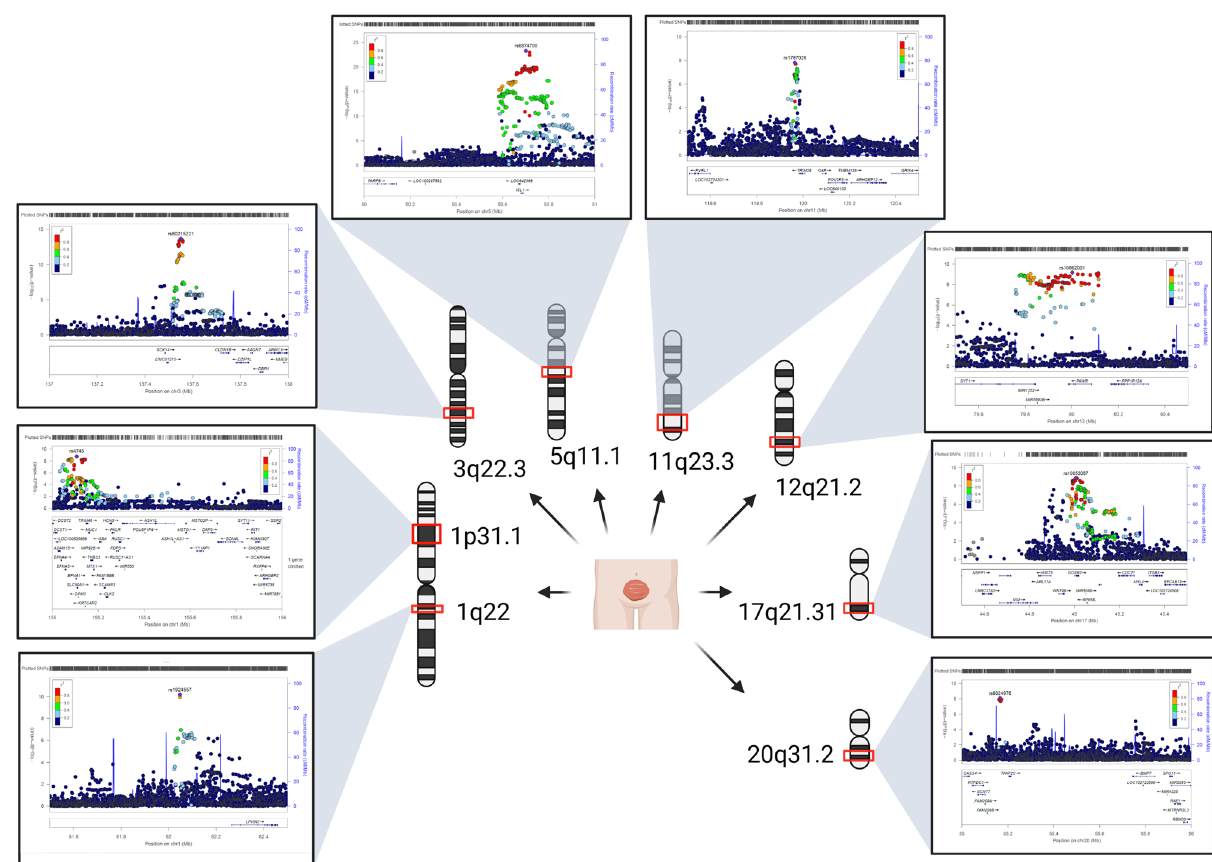
Fig. 1 Chromosome regional association loci of CBE. The eight CBE regional association loci (red boxes in chromosomes) reside in chromosome 1, 3, 5, 11, 12, 17, and 20. In the panels, details of the genome-wide association loci: every dot represents an SNP ( x axes) plotted to the relative – log 10 ( P value) ( y axes). SNP are colored according to the relative r 2